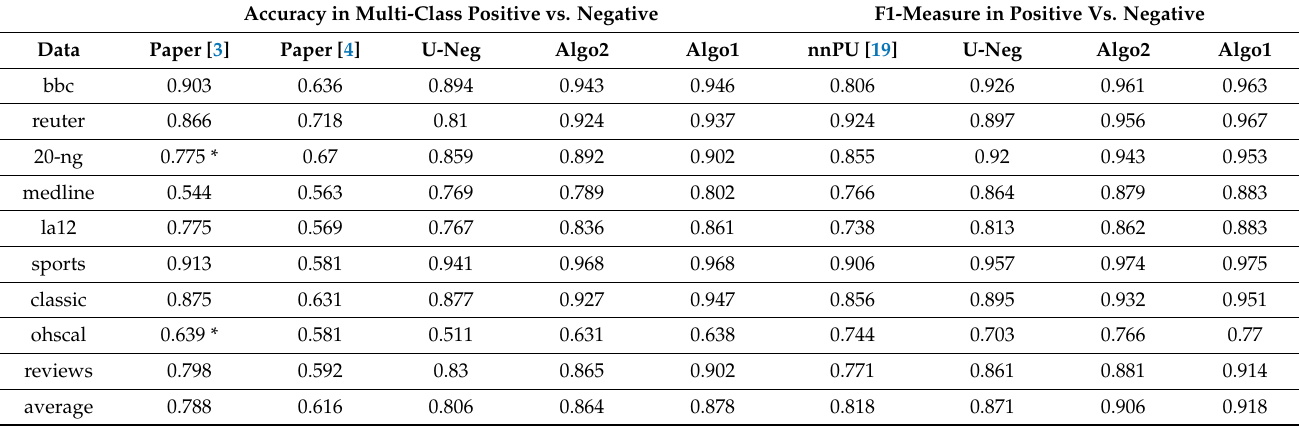
Table 3. Performance comparison by accuracy and F1-measure when 20% of data samples randomly selected from each class constitute unlabeled negative data.